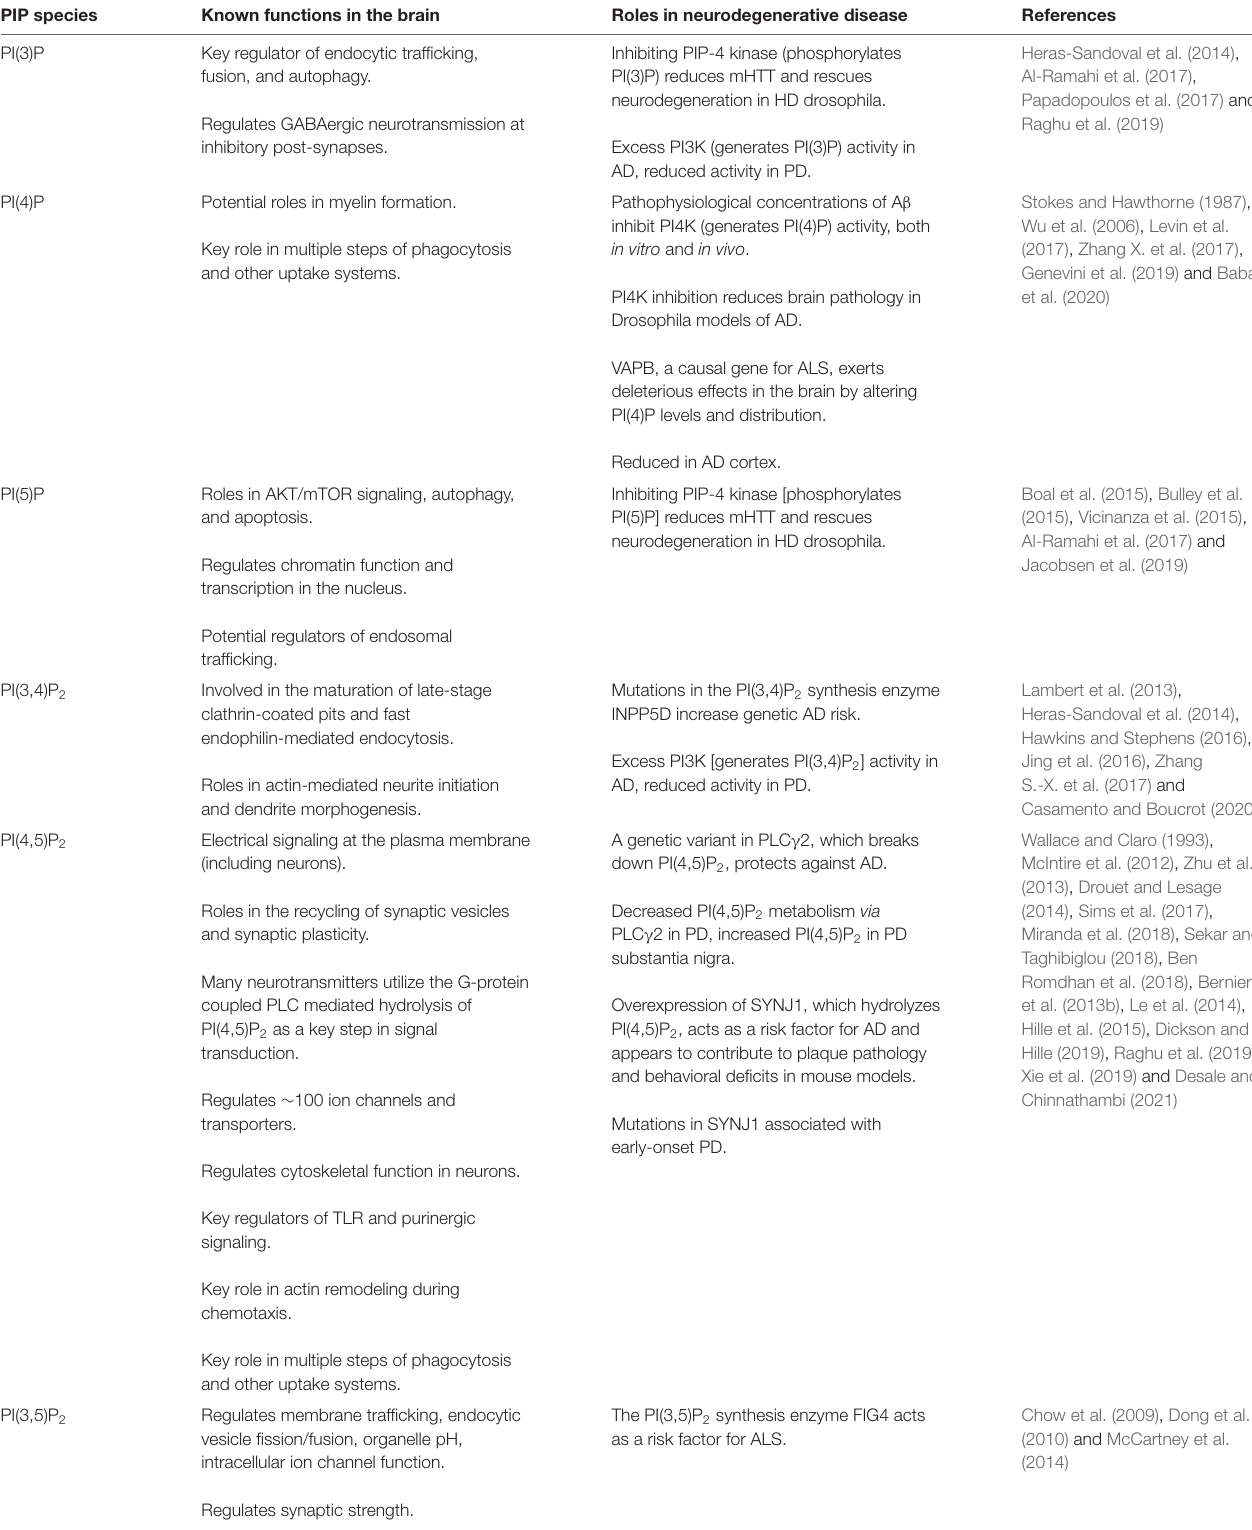
TABLE 1 | Known functions of phosphoinositide (PIP) species within the brain and roles in neurodegeneration. PIP